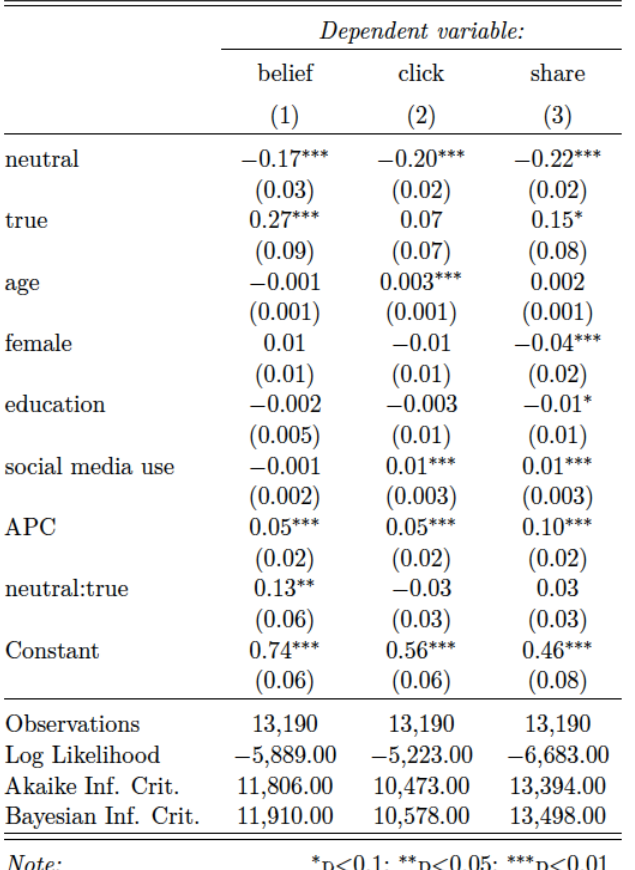
Table C3. Predicting outcomes with controls: